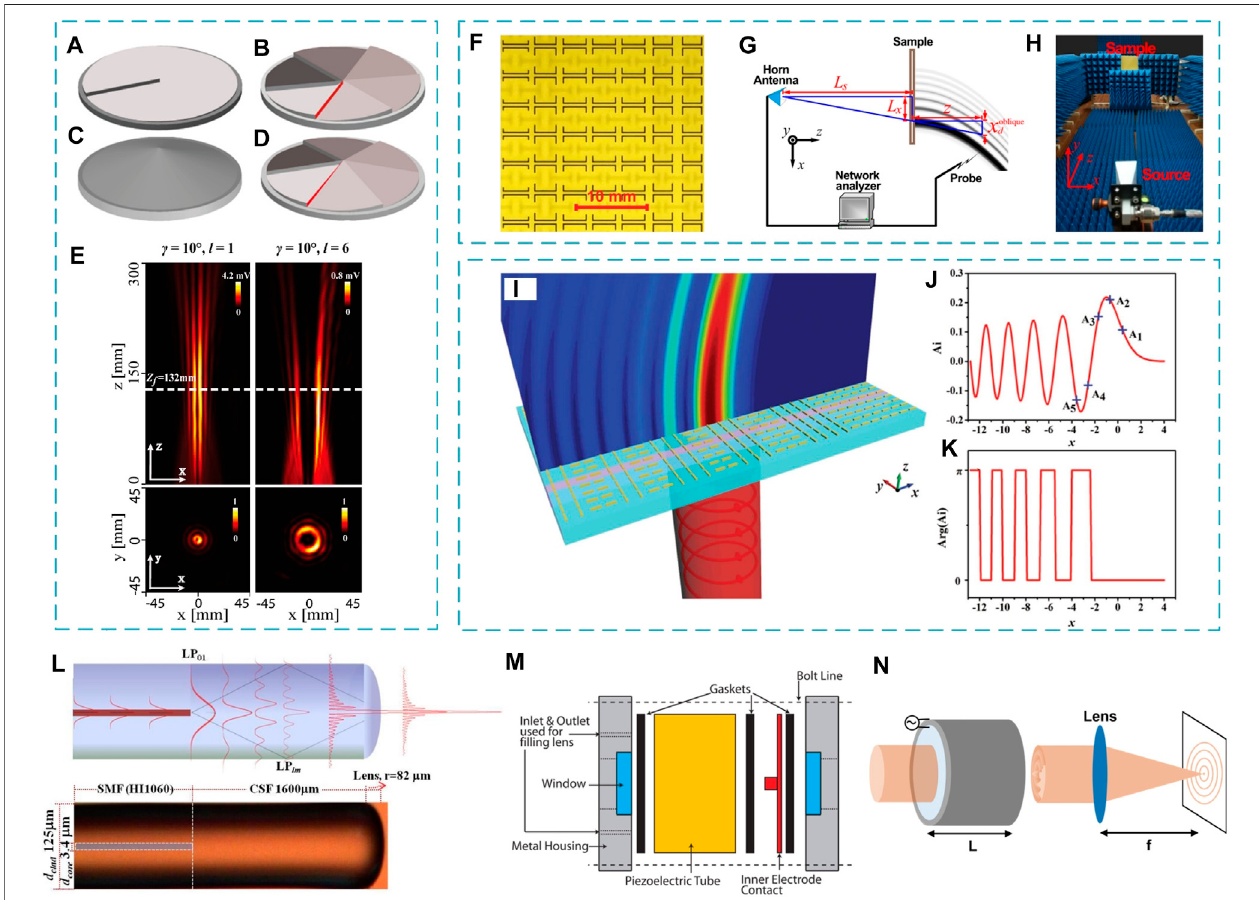
FIGURE6| SchematicsoftheSPPwiththeTCsof (A) 1and (B) 6, (C) theaxicon,and (D) thehelicalaxiconwiththetopologicalchargeof6. (E) Experimentalbeam pro fi les of the high-order Bessel beams created by the helical axicons. The fi rst (second) row shows the longitudinal (transverse) pro fi les [66]. (F) A part of the fabricated metasurface to convert the nondiffracting Airy beam in the microwave regime. Near- fi eld scanning (G) layout and (H) experimental setup for the Airy beam generation in themicrowaveregime[67]. (I) SchematicsofaplasmonicmetasurfacecapableofproducingtheAirybeamusingthegoldnanorod. (J) Linearpro fi leofAiryfunction. Bluelabelsmarktheamplitudevaluesusedforamplitudemodulation. (K) BinaryphasepatternoftheAirybeam[68]. (L) (Top)SchematicofBessel-likebeamgeneration (BBG)intheall- fi berdevicethroughmulti-beam interference.(Bottom) Photographicimageofthemanufacturedall- fi berBBGdeviceandthecorrespondinggeometrical scales [69]. (M) Components of the TAG lens [70, 71]. (N) Geometry of the cylindrical acousto-optic modulator for generating the ultra-high speed dynamic Bessel beams [72]. Reproduced with permission from OSA [66, 71]; APS [67], and Wiley [73]. Reproduced from OSA [69, 72].